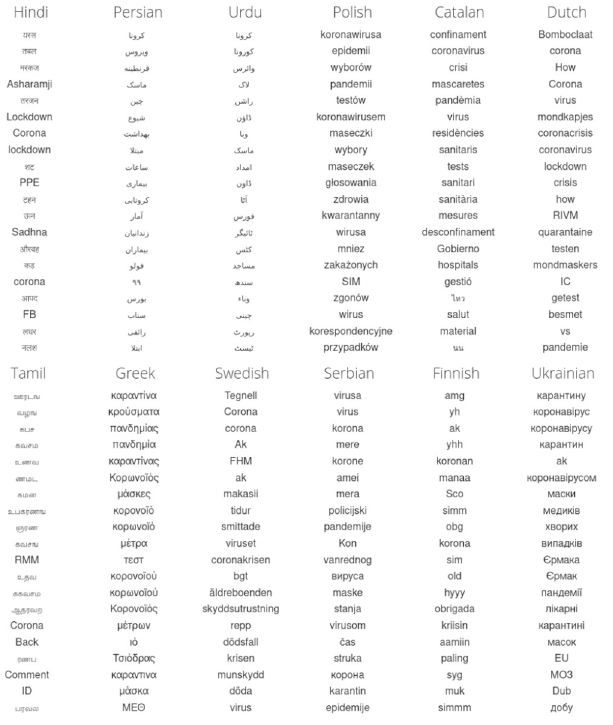
Fig 3. Continuing on from Fig 2: Top 20 1-grams for the second 12 of 24 languages we study for April 2020 relative to April 2019.